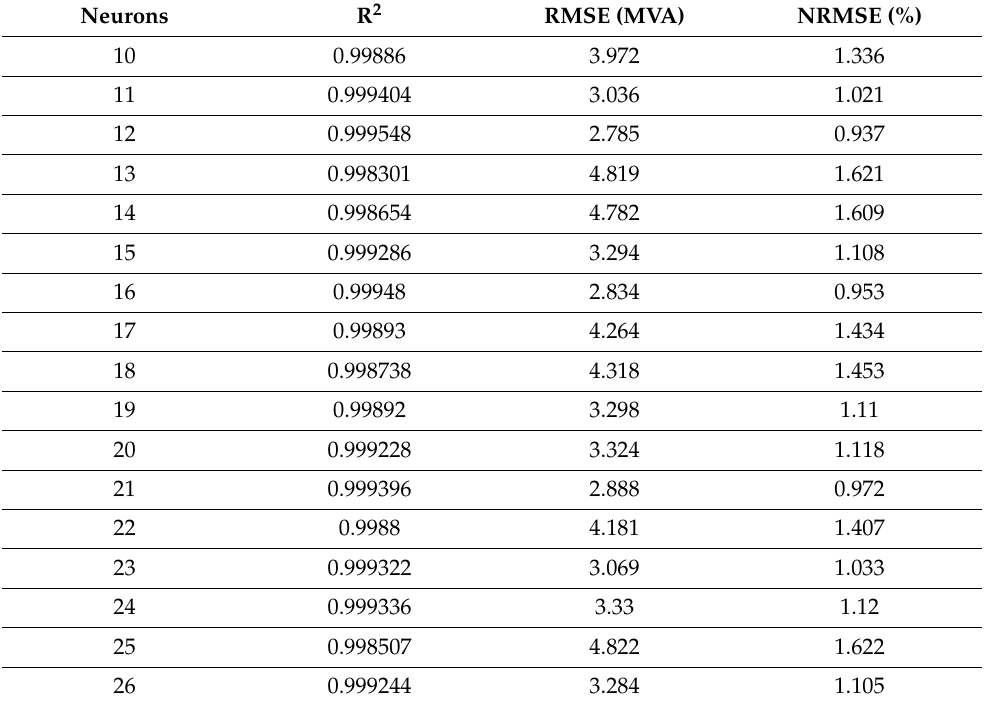
Table 3. Performance of Artificial Neural Network (ANN) models in the validation